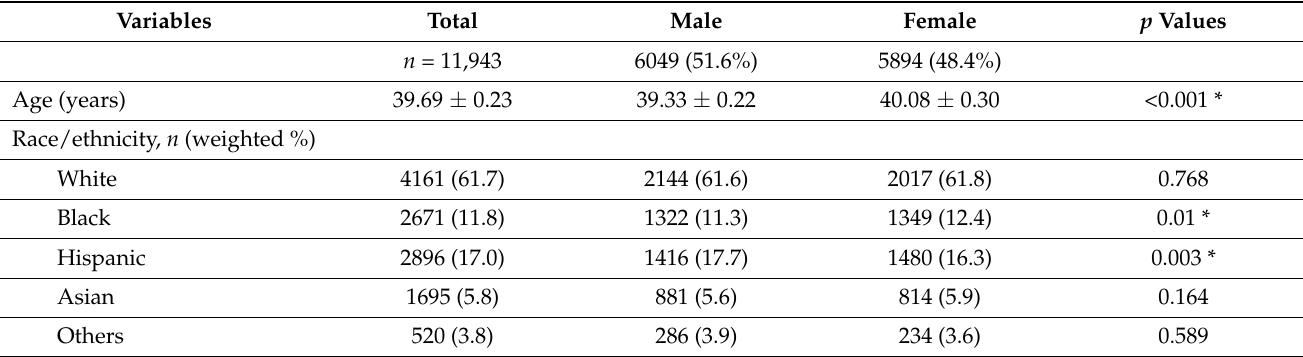
Table 1. Demographics characteristics stratified by sex, NHANES